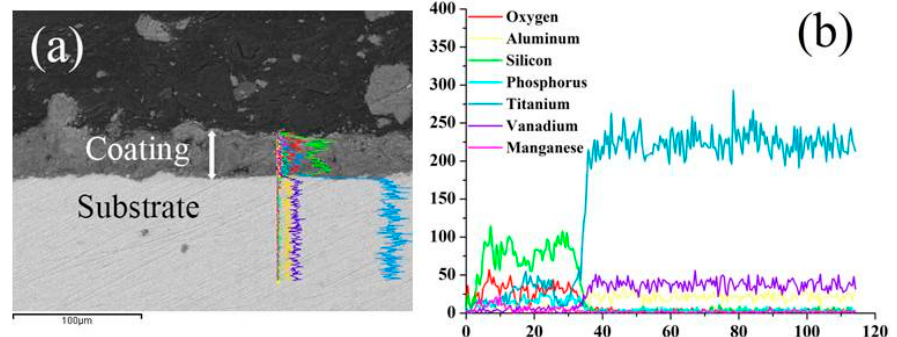
Figure 6. EDX analysis of the sample prepared with 0.8 g/L concentration of KMnO 4 : ( a ) Cross-sectional morphology of the MAO coating; ( b ) EDX elemental line scans.